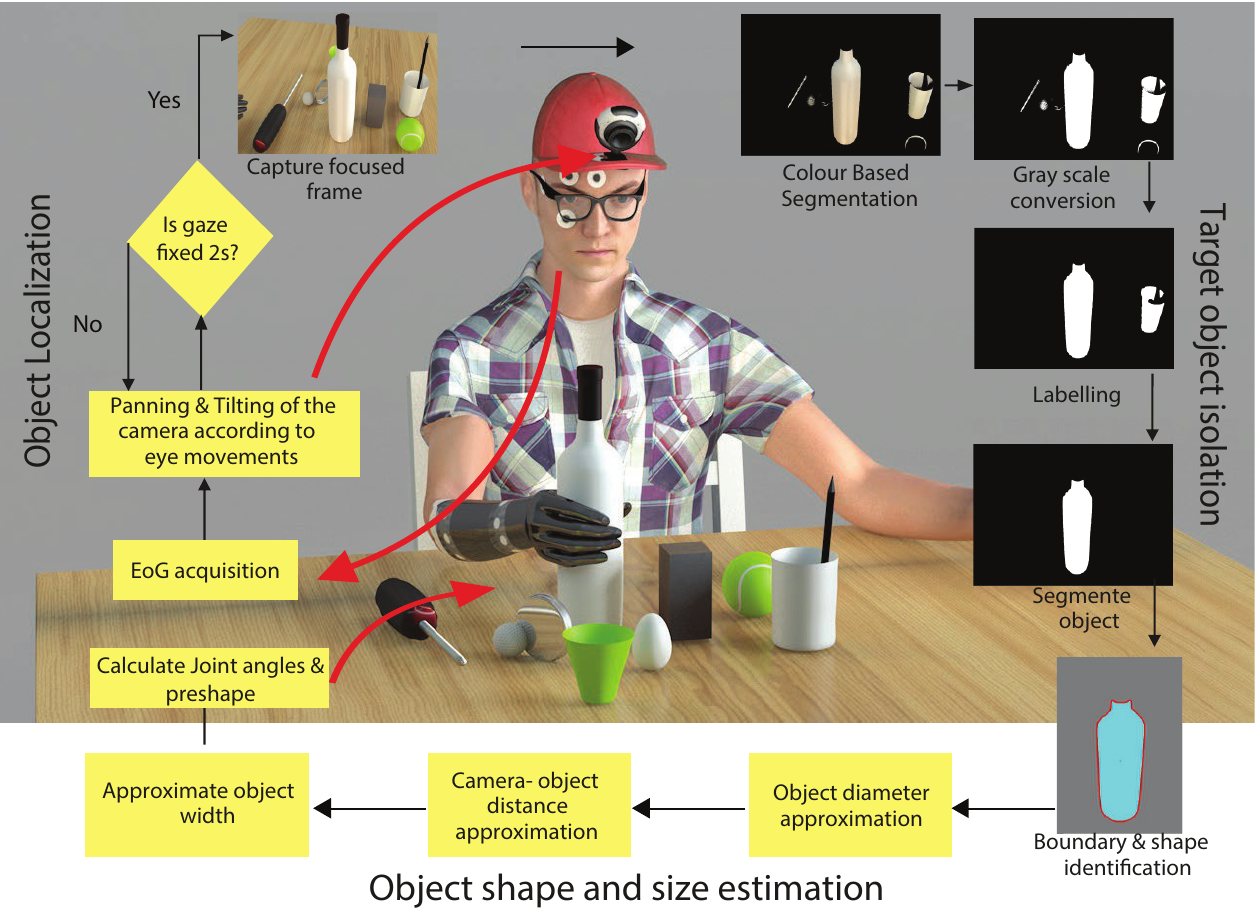
Figure 1. The schematic process flow diagram of the EOG-driven computer vision system for grasp control. The grasp assistive device is illustrated here with a black sleeve. (This is a schematic of the overall experimental process. In this study, we did not test the developed vision system with any assistive